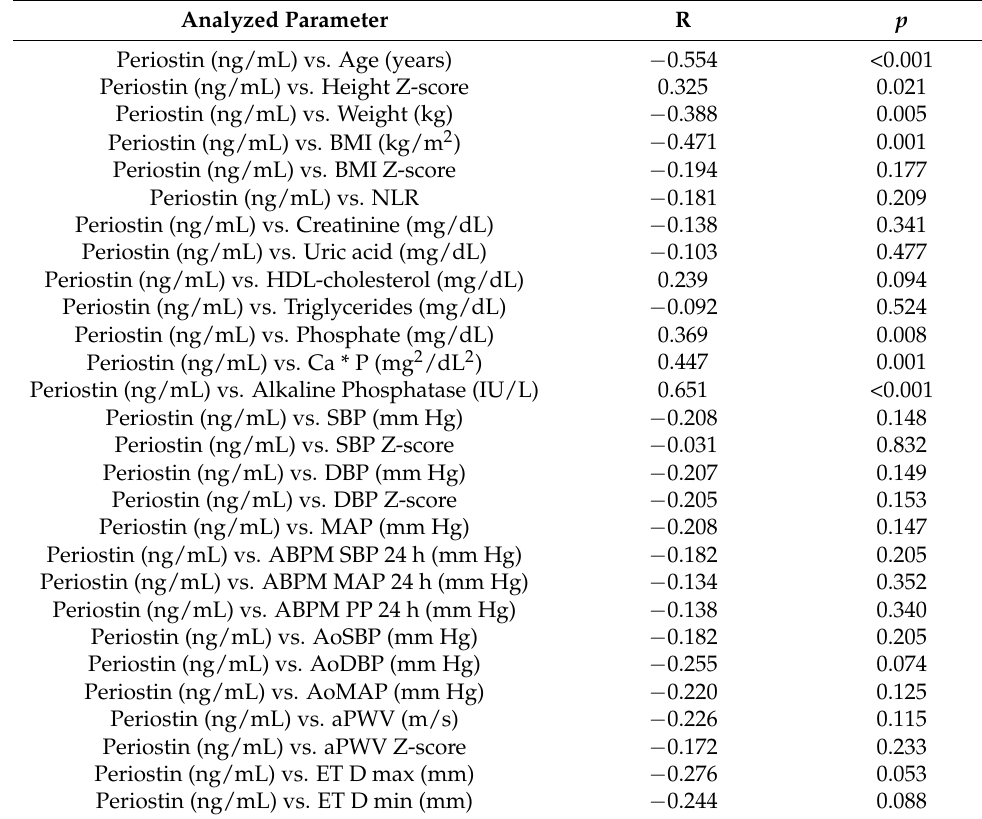
Table 3. Correlations of periostin concentration with clinical, biochemical parameters, blood pressure, and arterial damage parameters in 50 children with primary hypertension.